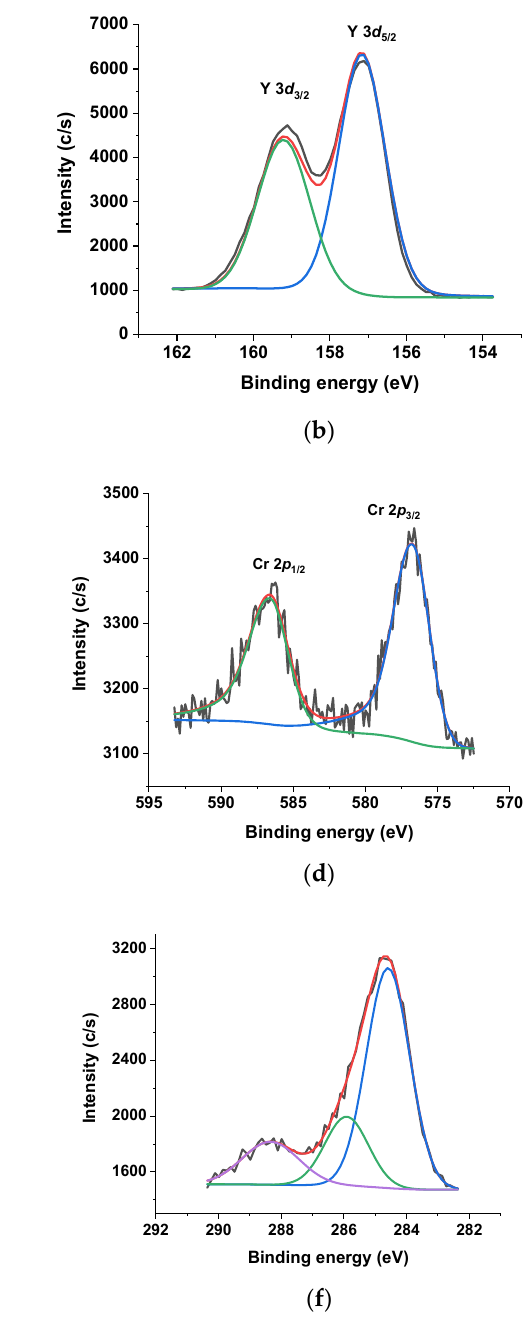
Figure 9. ( a ) XPS survey spectrum, ( b ) Y 3d, ( c ) Fe 2p ( d ) Cr 2p , ( e ) O 1s and ( f ) C 1s core levels for spent EC1YIG samples. Reaction conditions: EB to H 2 O 2 molar ratio of 1 using 1.3 mol of acetone as solvent, temperature of 50 ◦ C and a catalyst mass of 50 mg within 360 min of